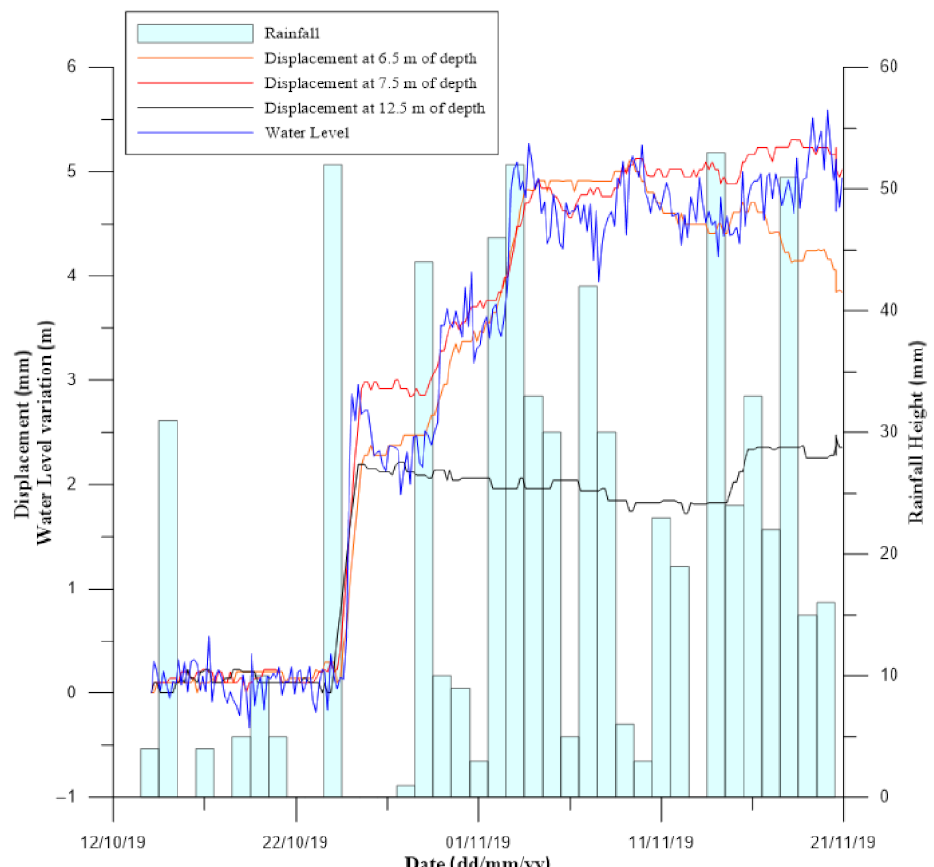
Figure 7. Comparison between rainfall height, water level variations and displacements recorded by a MUMS-based automatic inclinometer on a landslide in northern